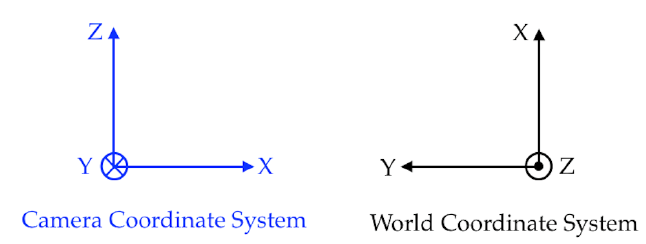
Figure 7. Positioning initialization pipeline.